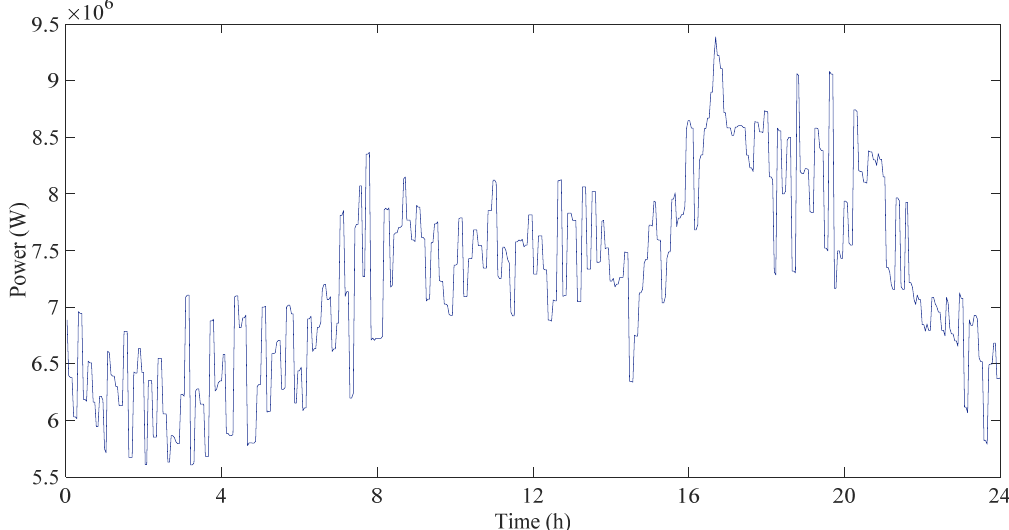
Figure 11. Suppressing hydraulic power used to complement the intermittent injection of wind power. The “W” is short for the unit of coal-fired power, wind power and load demand, and the “h” is short for the time unit.